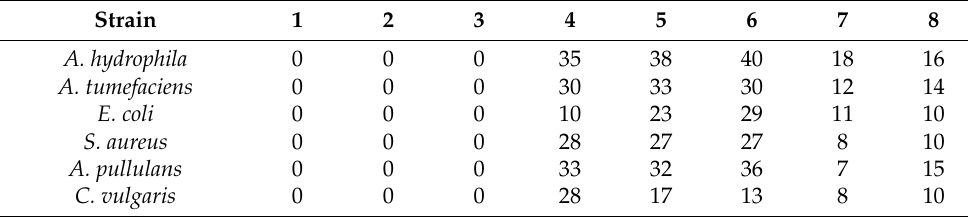
Table 2. Growth inhibition zones (mm) determined by agar well diffusion